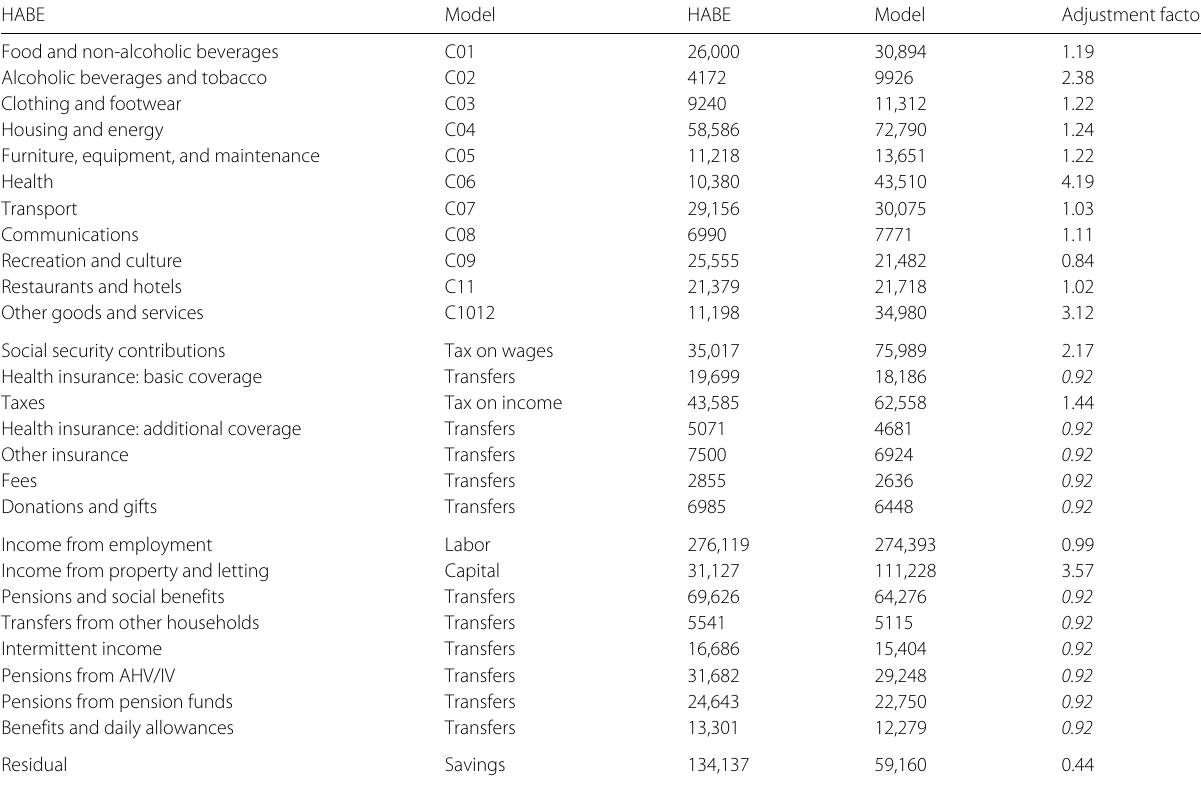
Table 12 Income and expenditure categories aggregated from household survey data compared with national accounts (numbers are in million Swiss Francs)